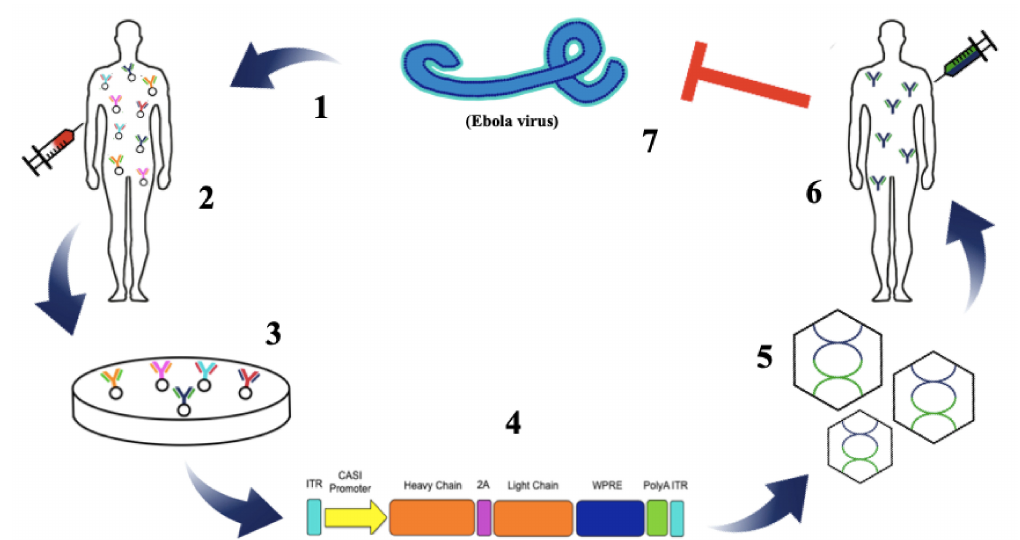
Figure 1. Schematic representation of adeno-associated virus vectored-immunoprophylaxis (AAV VIP) against Ebolavirus. Ebolavirus infects a healthy patient causing the onset of Ebola hemorrhagic fever (EHF)( 1 ).BcellsareisolatedfromthebloodofanEbolavirusdisease(EVD)survivor( 2 ). Potentantibodies are isolated for further development and characterization ( 3 ). Variable-heavy and variable-light chains of selected mAbs are cloned into the AAV vector ( 4 ). AAV vectors expressing the potent mAb against ebolavirus are manufactured ( 5 ). Individuals susceptible to ebolavirus infection are intramuscularly administered AAV-mAb vector ( 6 ). mAbs are secreted from the AAV-mAb transduced muscle cells into the blood stream and circulate throughout the blood, protecting against ebolavirus infection ( 7